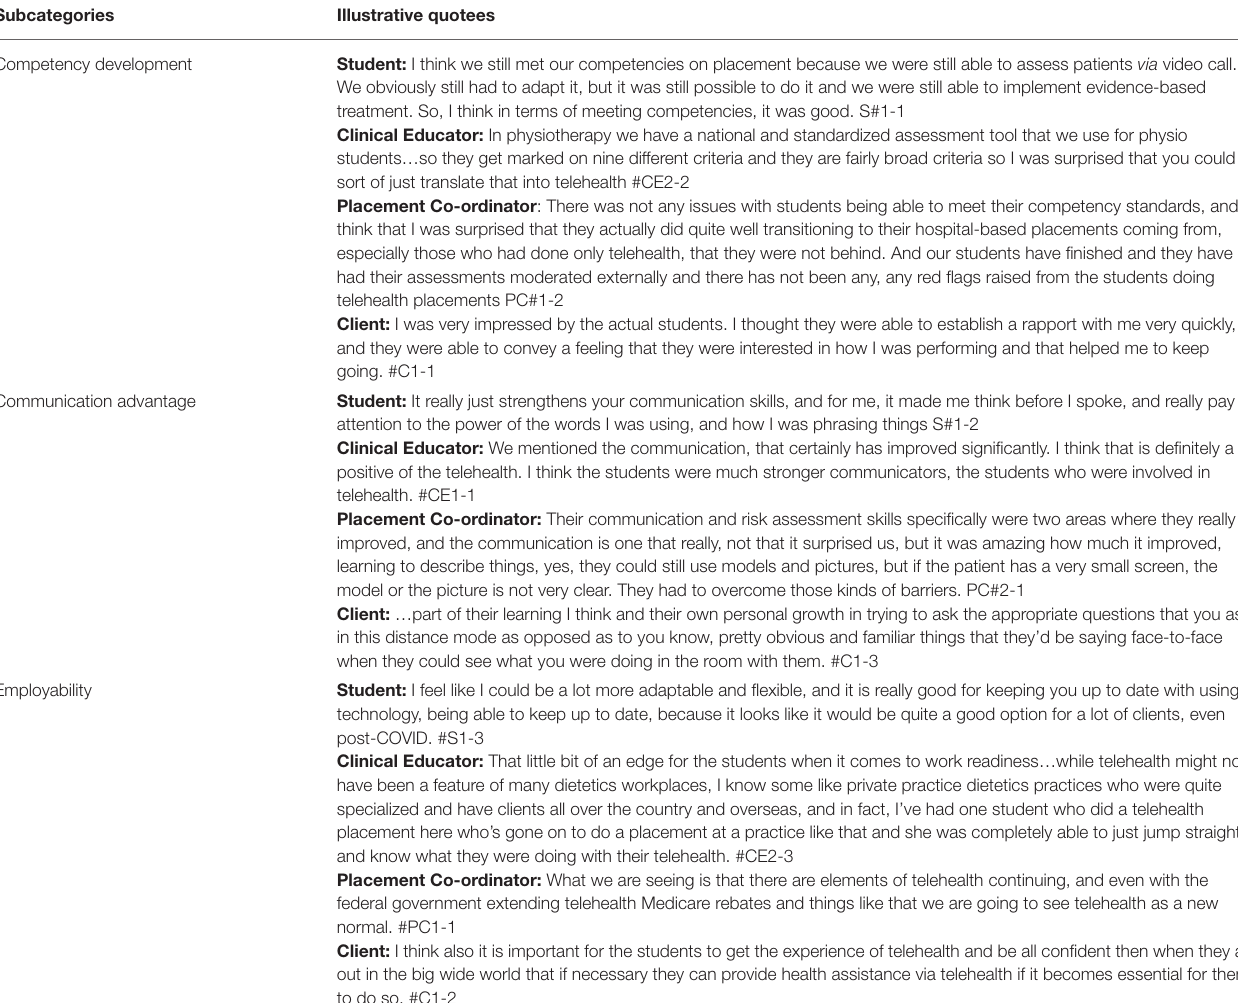
TABLE 2 | Theme 1: Telehealth placements support competency development and graduate employability.